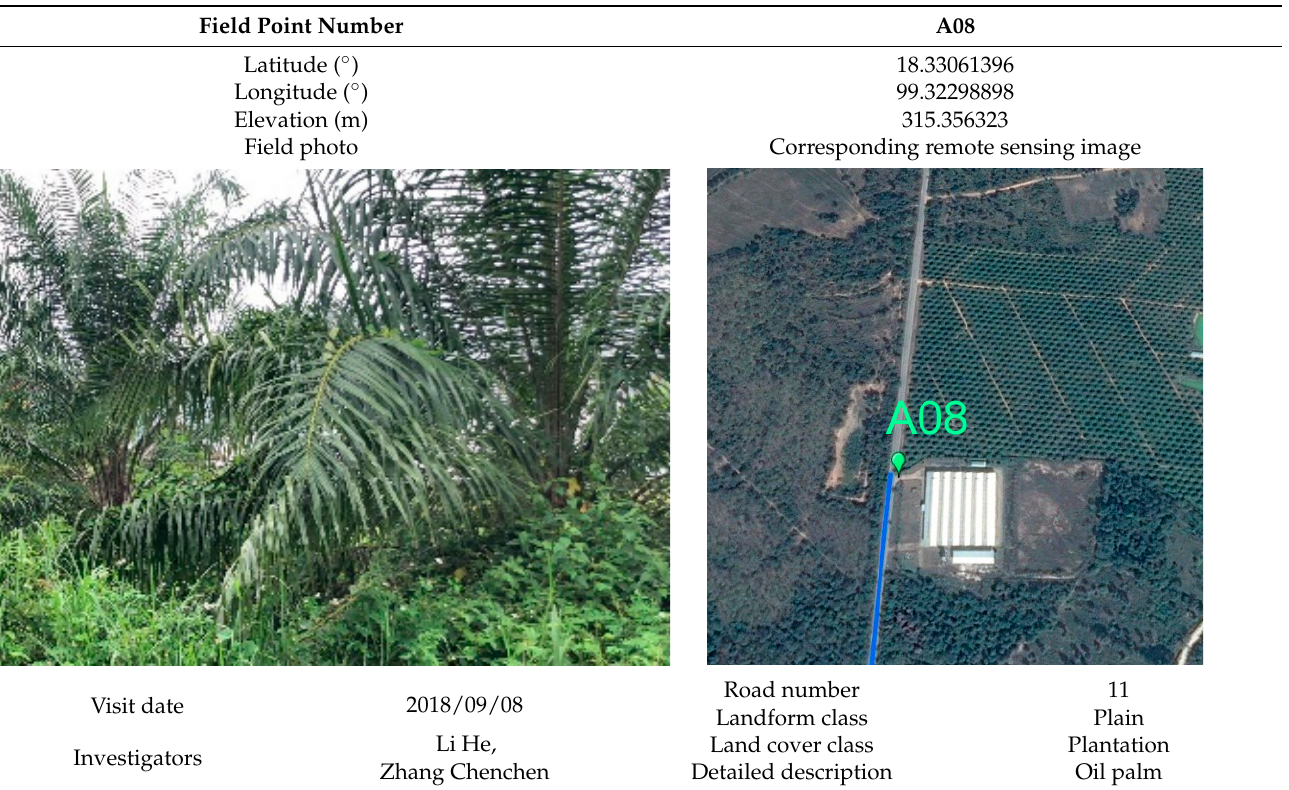
Table 3. An example of a field collection point record.